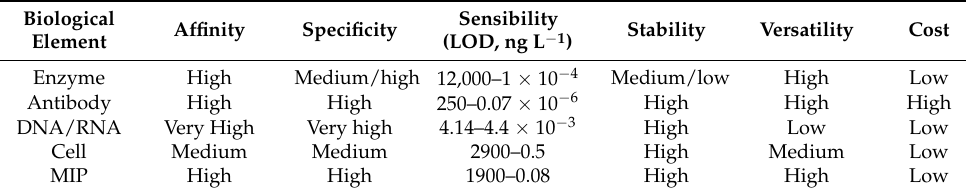
Table 1. Comparison between different biological recognition